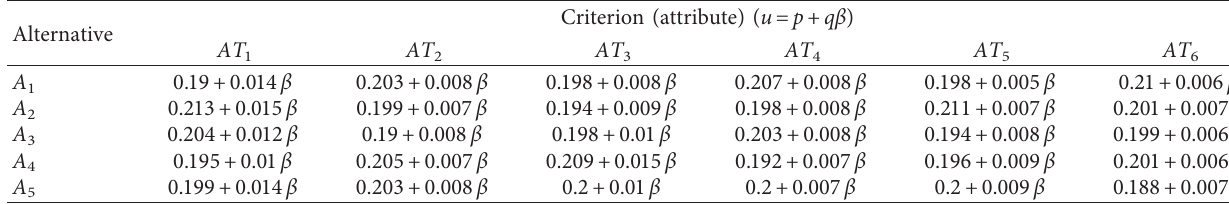
Table 3: The dual-connection number decision-making matrix.